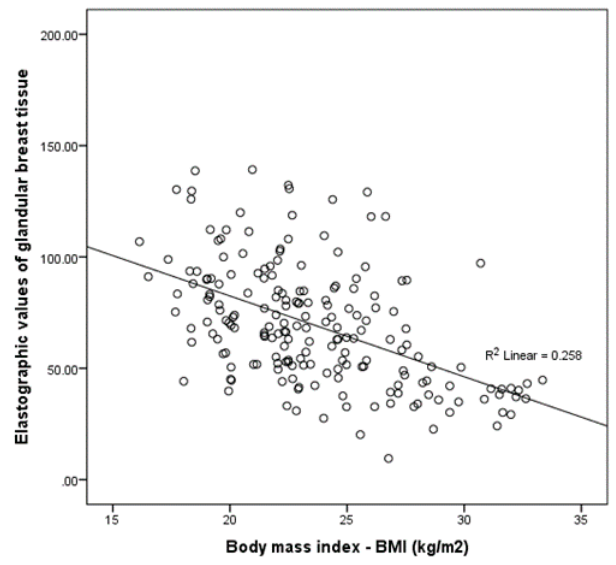
Figure 2. Pearson’s coefficient correlation ( r ) between elastographic values of glandular breast tissue and body mass index (BMI) (kg / m 2 ) ( r = − 0.508; p < 0.001; 95% Confidence Interval (CI) for r − 0.606 to − 0.395).